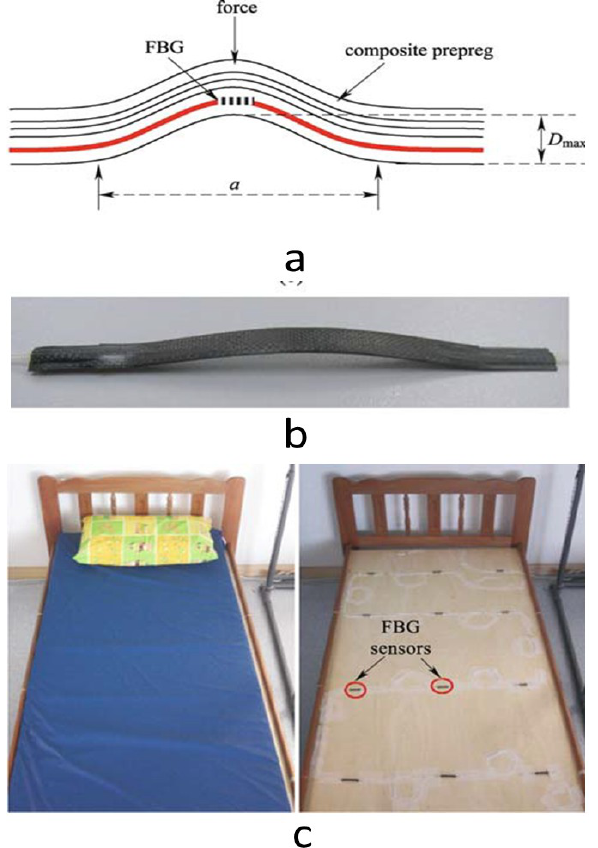
Figure 13. ( a ) A drawing illustrating the FBG embedded in a composite